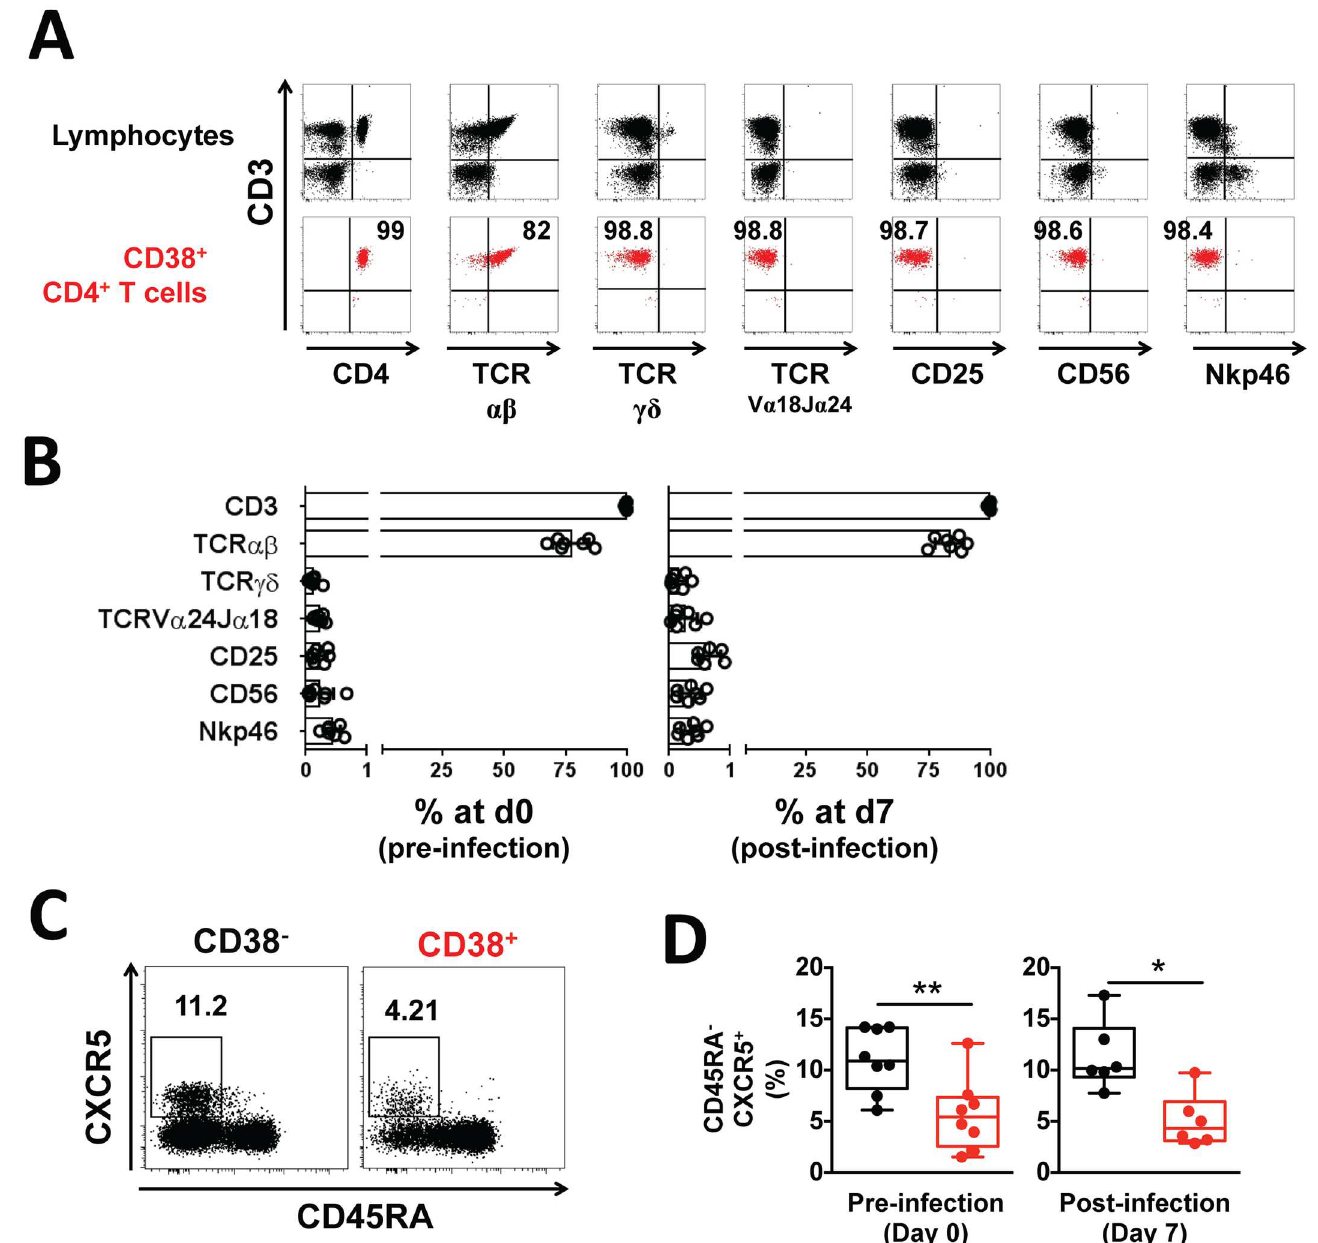
Fig 4. CD38 + CD4 + T cellsare a subsetof conventional TCR- αβ CD4 + T cells. Peripheral blood was collectedpriorto and seven days post- infection and the lineagephenotypeof CD38 + CD4 + T cells determined by flow cytometry. (A) Representative stainingof CD3, CD4, TCR- αβ ,TCR- γδ , TCR-V α 24J α 18, CD25, CD56 and Nkp46 withinCD38 + CD4 + T cells (red)or total lymphocytes (grey) fromone volunteer. (B) Mean frequencyof CD3, TCR- αβ ,TCR- γδ ,TCR-V α 24J α 18, CD25,CD56 and Nkp46 positive cells withinCD38 + CD4 + T cells circulating priorto and seven days post-infection. Graphs show combineddata fromseven volunteers fromone cohort; errorbars indicateSD. (C) Concatenated plot representing the frequencyof CXCR5 + CD45RA - cells withinCD38 + CD4 + T cells or CD38 - CD4 + T cells from6 volunteers at seven days post infection. (D) Meanfrequencyof CXCR5 + CD45RA - cells withinCD38 + CD4 + T cells (red)or CD38 - CD4 + T cells (black) priorto and seven days post infection. Graphs show combined data fromeight (pre)and six (post)volunteers fromone cohort.Statisticaldifferences between CD38 - and CD38 + CD4 + T cells were determined using the non-parametricWilcoxon test;box and whisker plots indicatemedian,interquartilerange and min-max; * , p < 0.05; ** , p < 0.01.